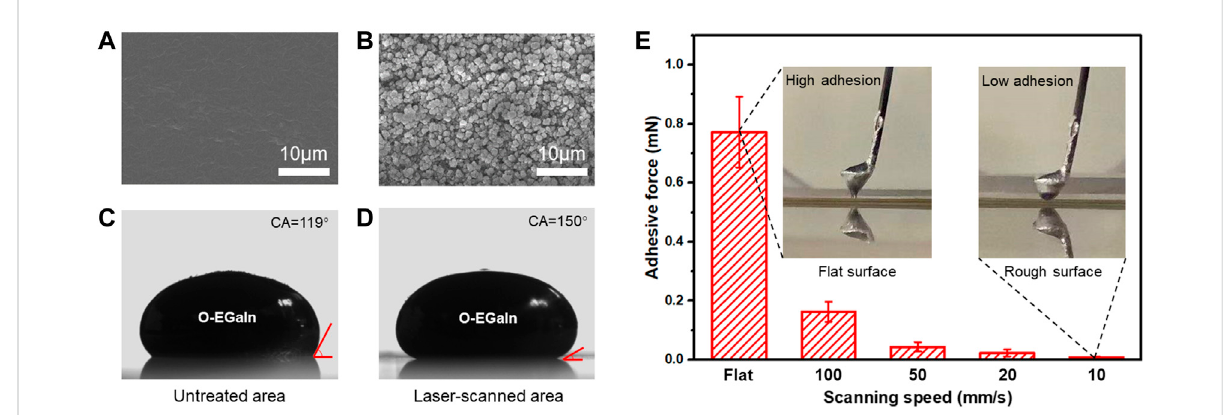
FIGURE 3 Wettability of O-EGaIn on different PDMS surfaces. (A) SEM image of theuntreated PDMS surface. (B) SEM image of the fs laser-scanned PDMS surface. (C) O-EGaIn droplet on the untreated surface. (D) O-EGaIn droplet on the laser-scanned surface. (E) Adhesive force between O-EGaIn droplet and fs laser-scanned surface with different scanning